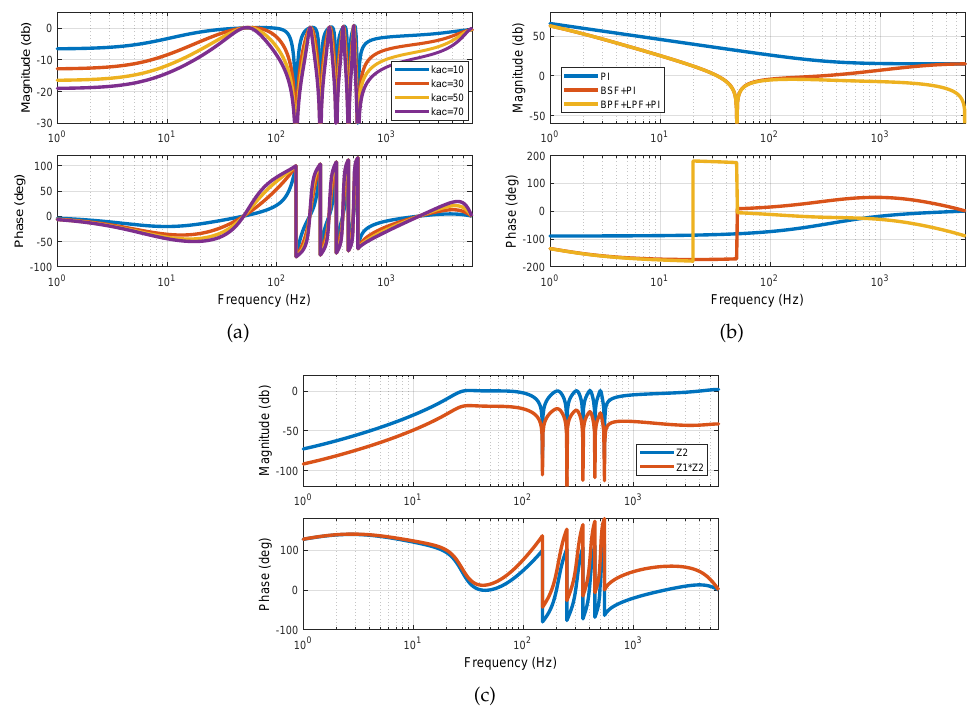
Figure 8. Frequency responses of different transfer functions used in parameter tuning. ( a ) The transfer function [ 1 + C 2,ac ( z ) P ( z )] − 1 ; ( b ) The transfer function C 2,dc ( z ) ; ( c ) The transfer function Z 2 ( z ) and Z 1 ( z ) Z 2 ( z )